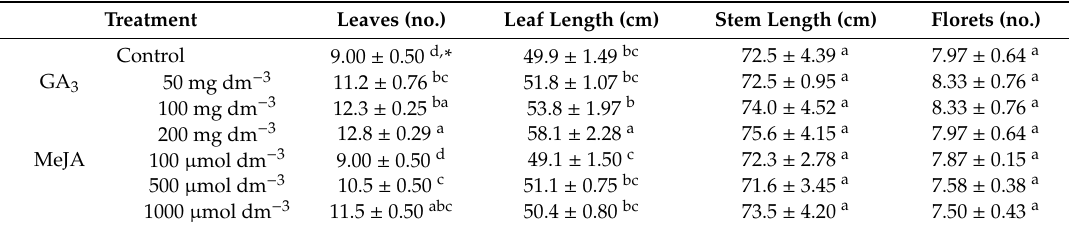
Table 1. E ff ects of GA 3 and MeJA on morphological traits of × Amarine tubergenii “Zwanenburg” at the beginning of anthesis.